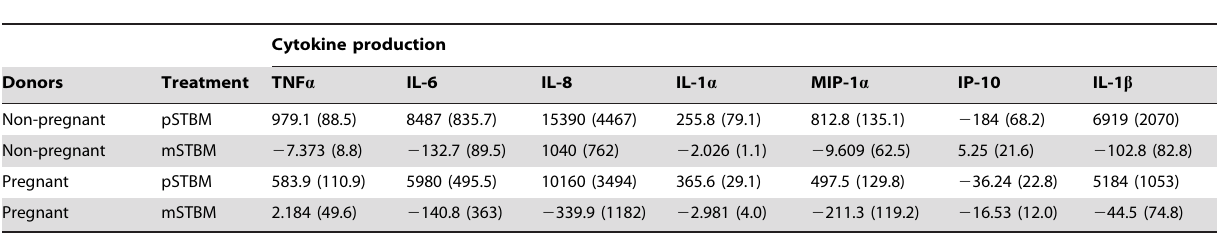
Table 1. Cytokine production is regulated by pSTBM but not mSTBM.